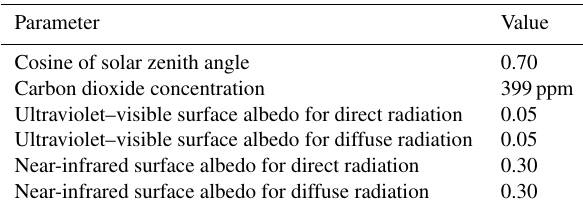
Table 5. Input parameters for the RRTMG